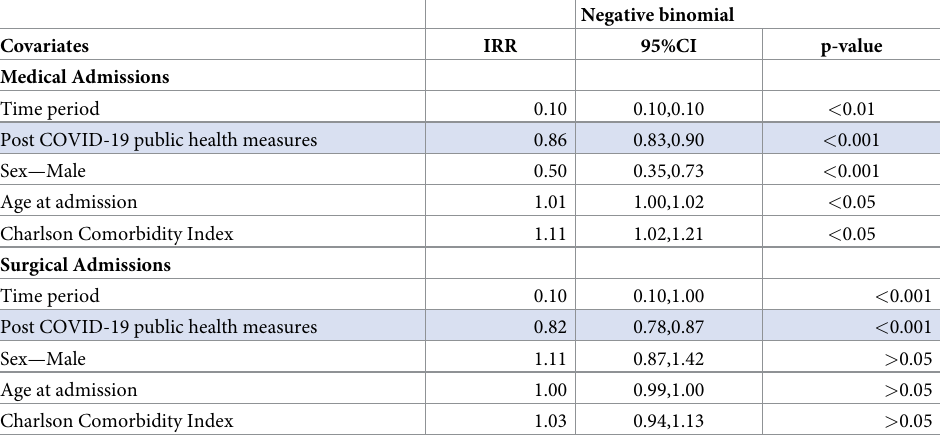
Table 2. Multivariable negative binomial regression with daily number of medical and surgical hospital admis- sions per day as the outcome comparing March 16-September 23, 2020 (post COVID-19 public health measures) to March 16-September 23, 2019.